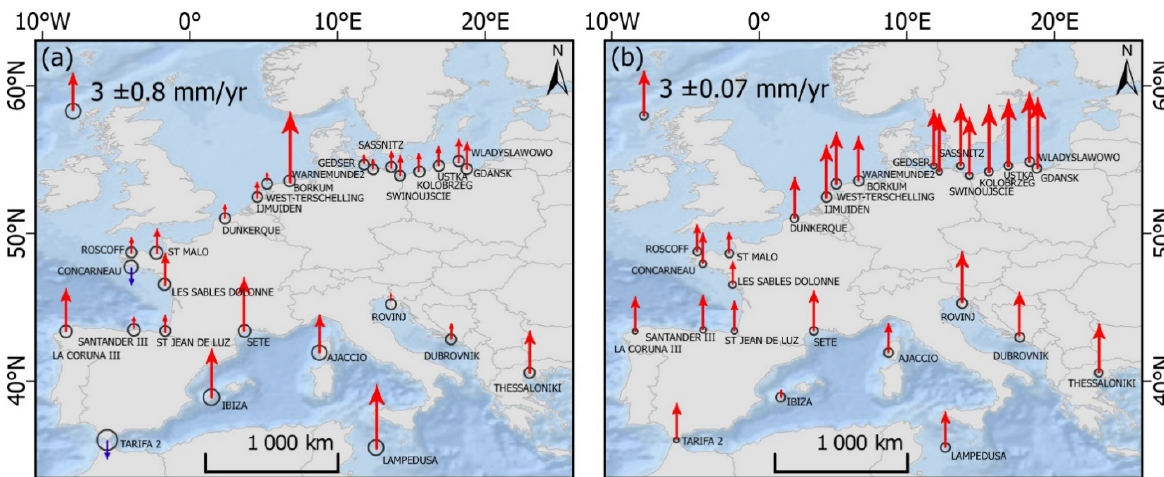
Figure 12. ( a ) Map of the linear trend in coastal stations estimated from different time series of TG data (TG data from the beginning of data to 2018). ( b ) Map of the linear trend in coastal stations estimated from different time series of SA data (SA data from 1993 to 2017); the units on both pictures are in mm/year. The linear trend standard errors are visualized by black circles. Positive values of the linear trend are visualized by a red arrow. Negative values of the linear trend are visualized by a blue arrow.